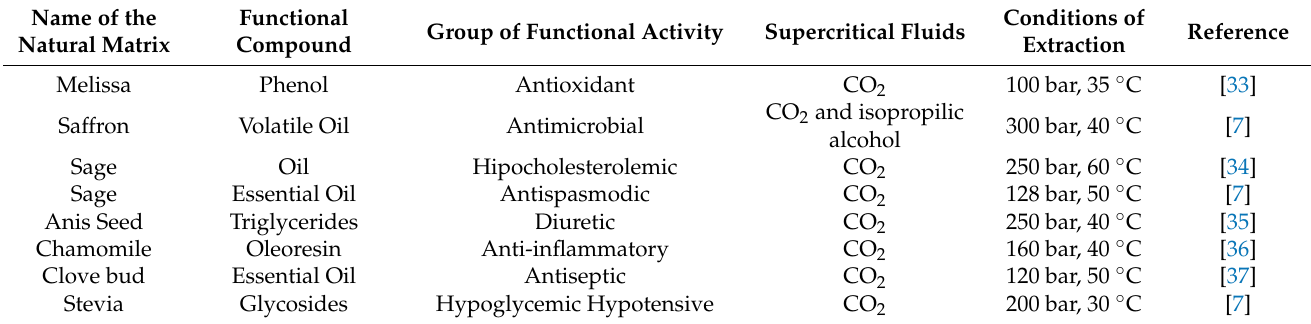
Table 3. Examples of groups of active compounds obtained by supercritical